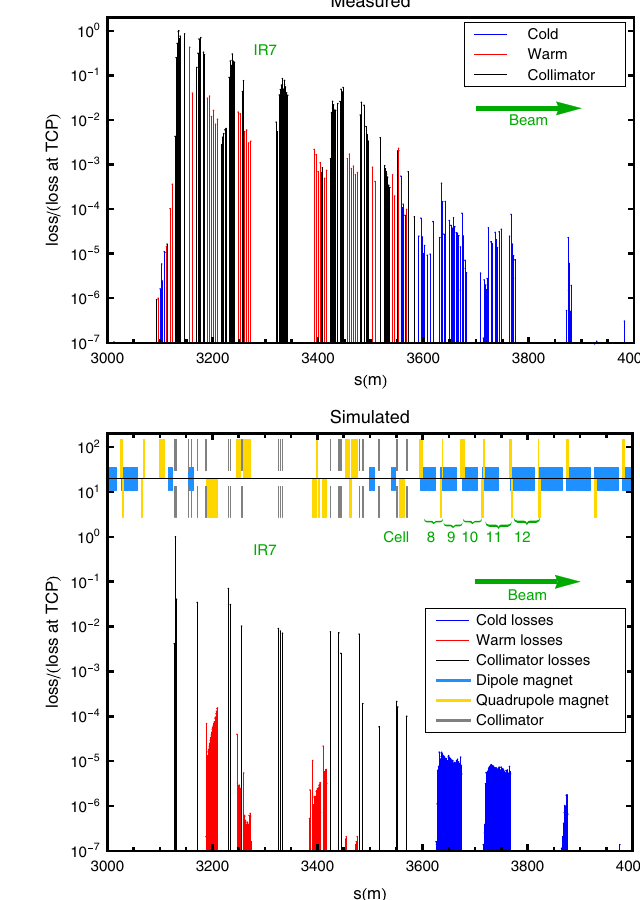
FIG. 7. Loss locations in IR7 (zoom of Fig. 6) from measure- ment (top) and SixTrack (bottom). The layout of the main magnetic elements (quadrupoles and dipoles) as well as the collimators is also shown, together with the LHC cell numbers at the cold loss